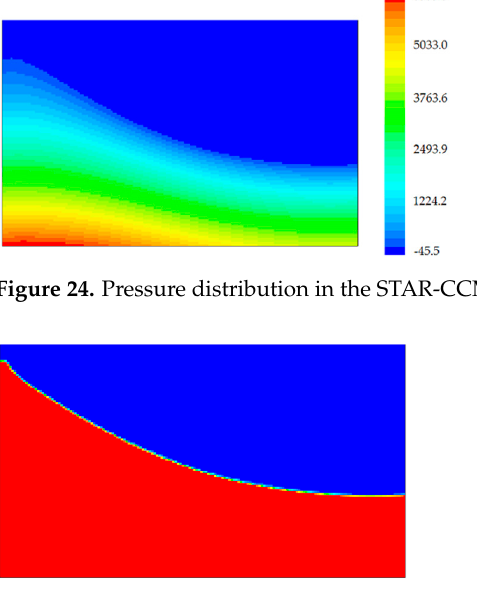
Figure 25. Flow pattern in the STAR-CCM+ simulation without the baffle.